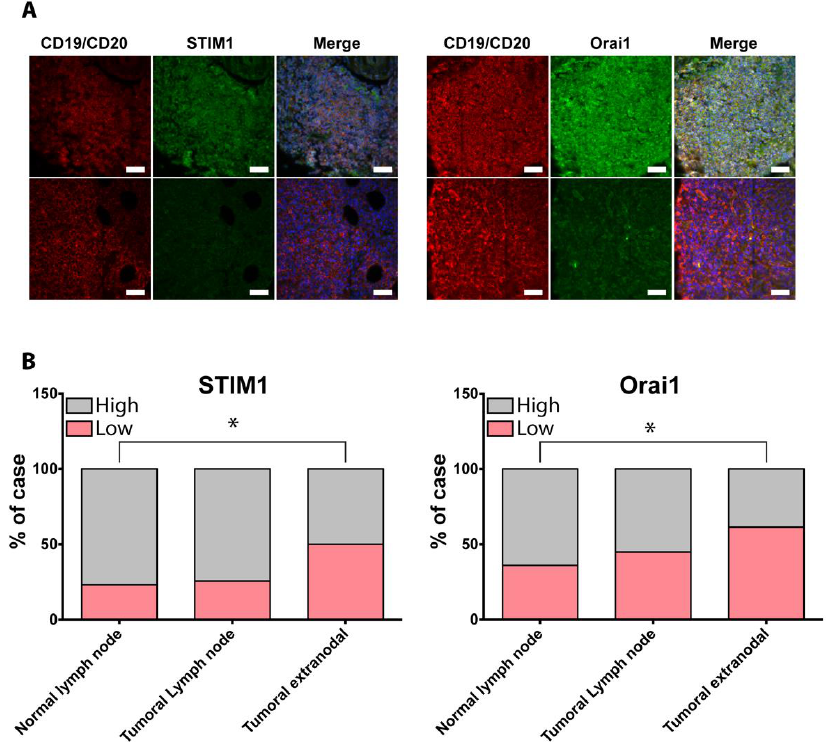
Figure 5. Orai1 and STIM1 expression is altered in extra-nodal DLBCL. ( A ) Representative immunofluorescent staining of STIM1 and Orai1 in normal lymph node and extra-nodal DLBCL under-expressing STIM1 or Orai1. Images were acquired using Leica DMI8 microscope equipped with a 40× oil immersion objective. TMA including samples from normal lymph node (n = 26), nodal (n = 43) and extra-nodal (n = 44) DLBCL was co-immunostained using Orai1 or STIM1 antibodies revealed by donkey anti-rabbit Alexa-488 (in green) and mouse anti-human CD20 and anti-human CD19 revealed by goat anti-mouse Alexa 532 (in red). Nuclei were stained with DAPI (in blue). Scale bar = 50 µm. ( B ) Quantification of STIM1 or Orai1 alteration in DLBCL samples. After acquisition of spot fluorescence on Icys laser scanning cytometer, a segmentation analysis base on phantoms was done to determine the percentage of CD20/CD19 positive cells expressing protein of interest for